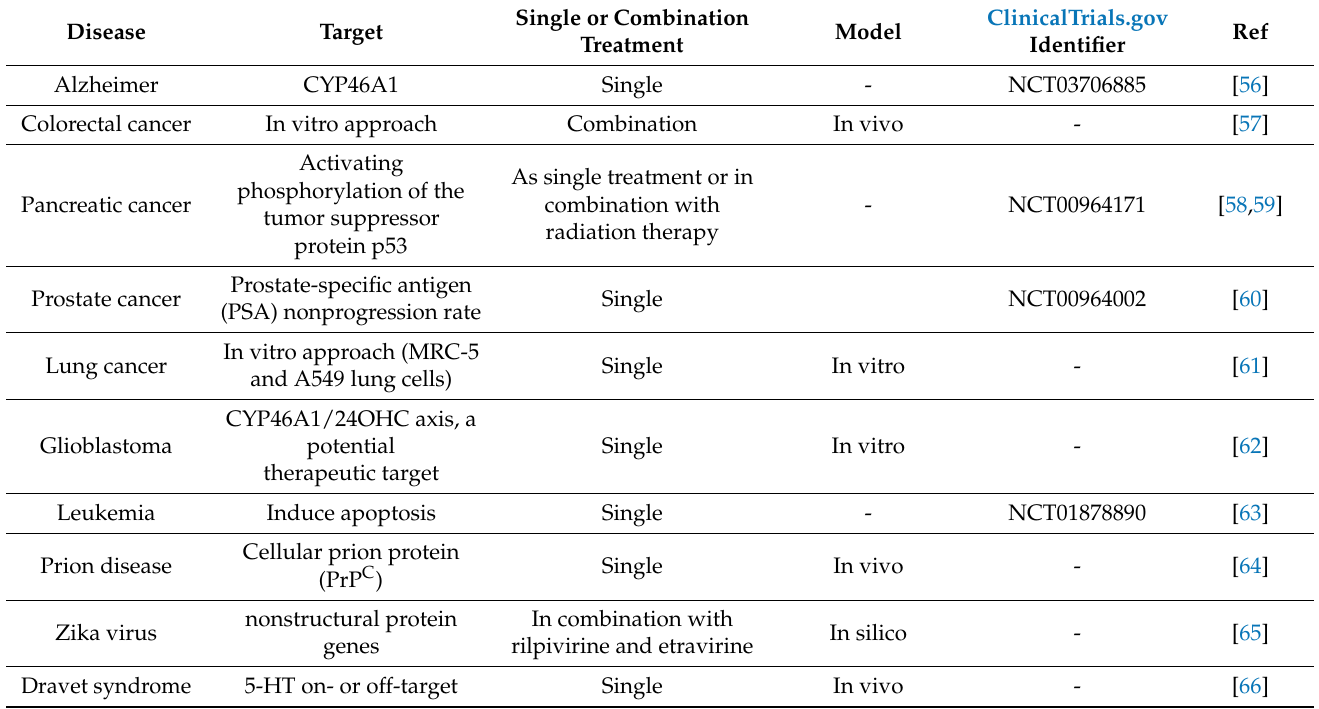
Table 1. List of diseases where it has been studied the efficacy of efavirenz as a repurposed drug. Some of these drugs reached clinical trials and are identified by the ClinicalTrials.gov